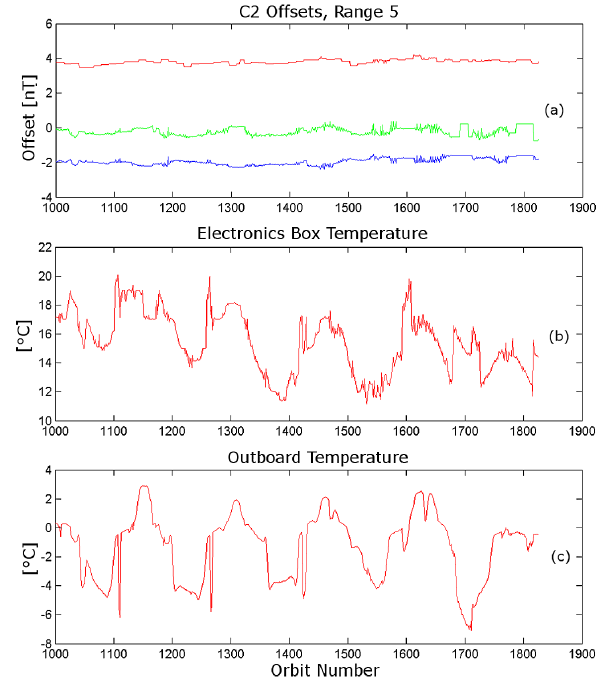
Figure 16. (a) C3 range 5 offsets ( O 1 in red, O 2 in blue and O 3 in green), (b) C3 electronics box temperature and (c) C3 out- board sensor temperature. Offsets shown in nanoteslas and temper- atures in degrees Celsius for orbits 1000–1825 (December 2006– February